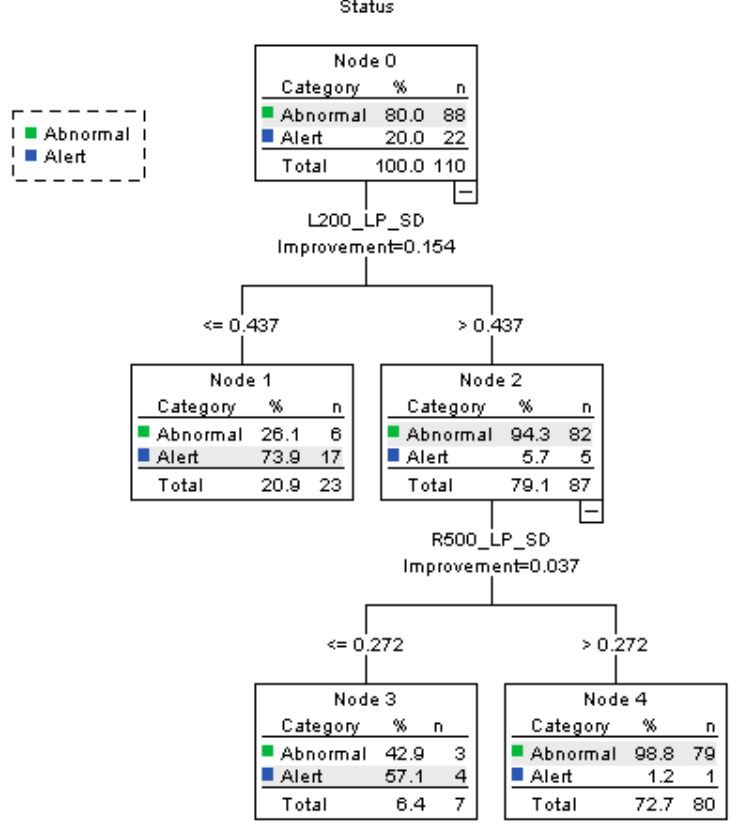
Figure 5. Decision tree diagram for the CART model of alert vs. abnormal.